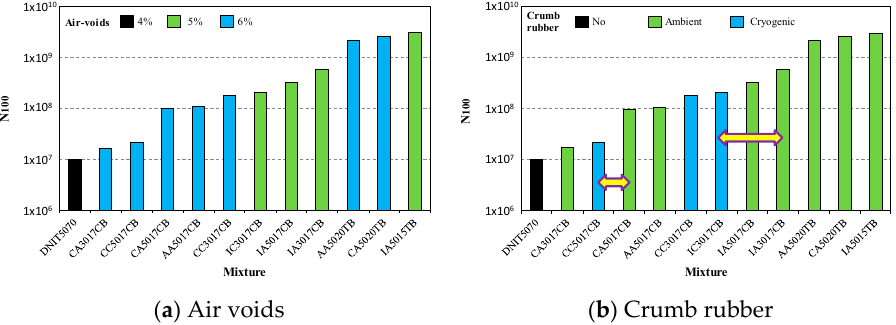
Figure 8. Influence of air voids ( a ) and crumb rubber ( b ) on fatigue resistance.